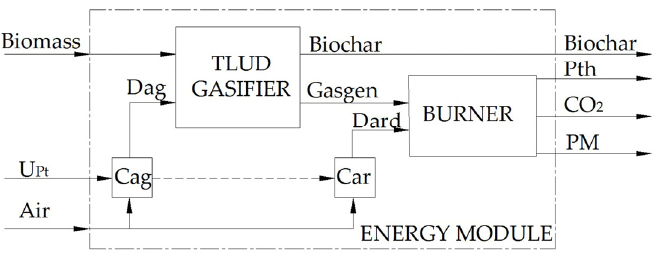
Figure 3. Block diagram of the TLUD energy module [13].